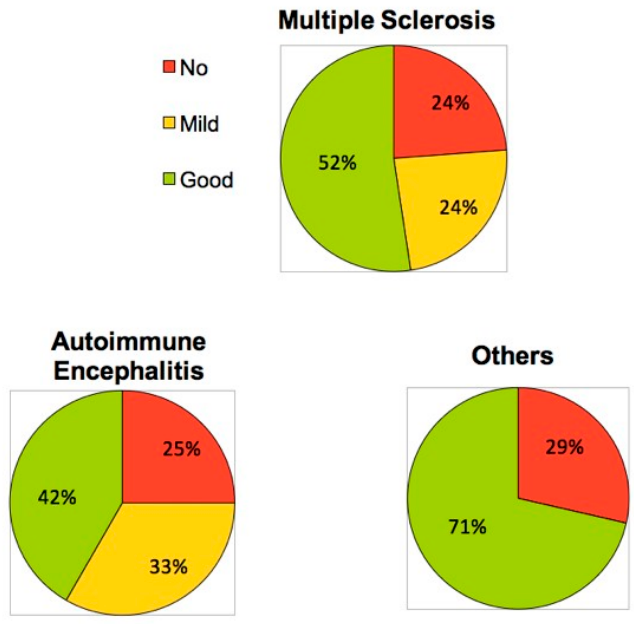
Figure 3. Clinical response to TPE across three subgroups of immune-mediated CNS disorders.